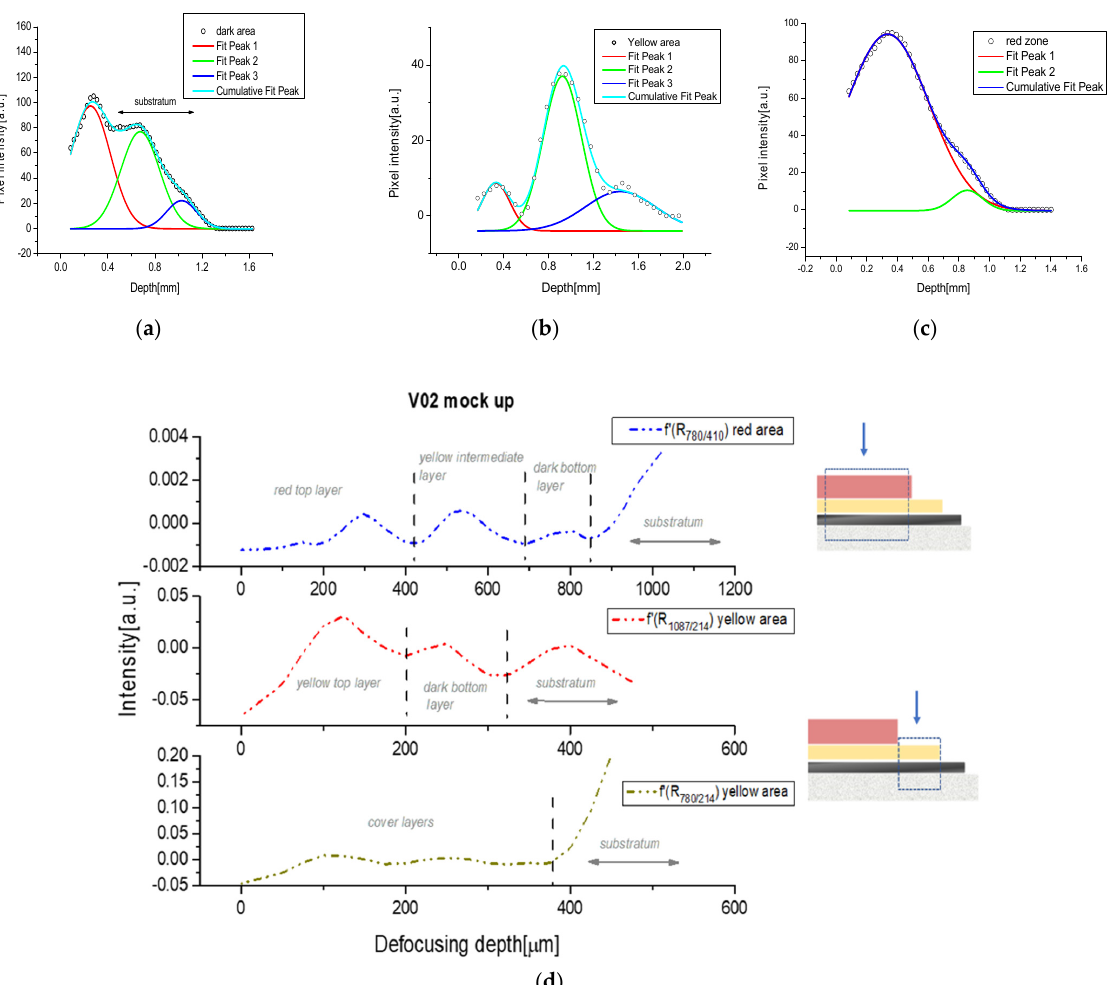
Figure 8. Layers fit of V02 sample obtained from PA stratigraphic images for: ( a ) the dark area, ( b ) the yellow area, ( c ) the red area; and ( d ) the same profiles obtained with the SORS technique.